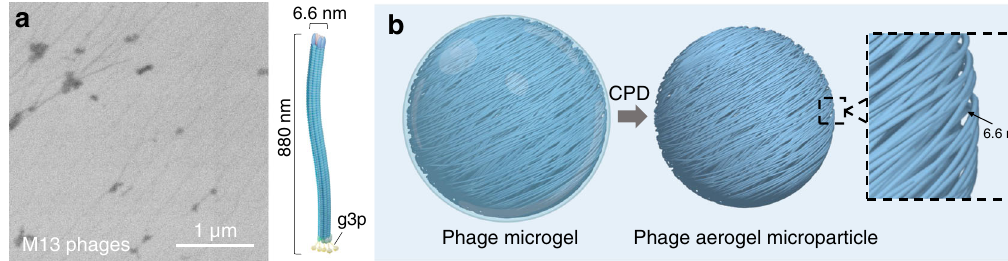
aligned nano fi brous texture on the microgel surface. d SEM images of the orderly aligned nano fi brous texture on a M13 phage microgel crosslinked by EDC; e SEM images of the nano fi brous texture on a M13+BSA microgel cross- linked by GA. ( n =5 independent experiments for a and c – e . GA glutaraldehyde, EDC 1-Ethyl-3-(3-dimethylaminopropyl) carbodiimide, BSA bovine serum